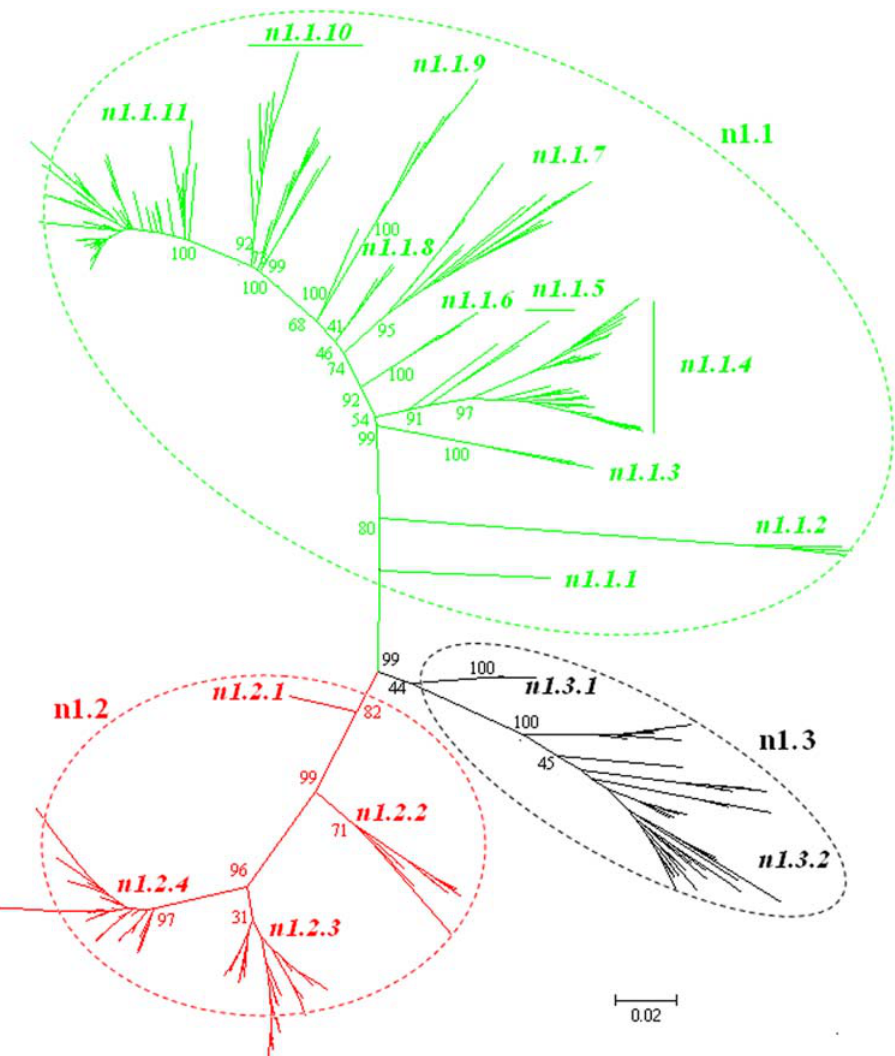
Figure 10. The panorama diversity of N1 influenza viruses which could be divided into 3 lineages, n1.1, n1.2 and n1.3, largely corresponding to avian, human and classical swine N1 influenza viruses. Bootstrap values were given at relevant nodes.